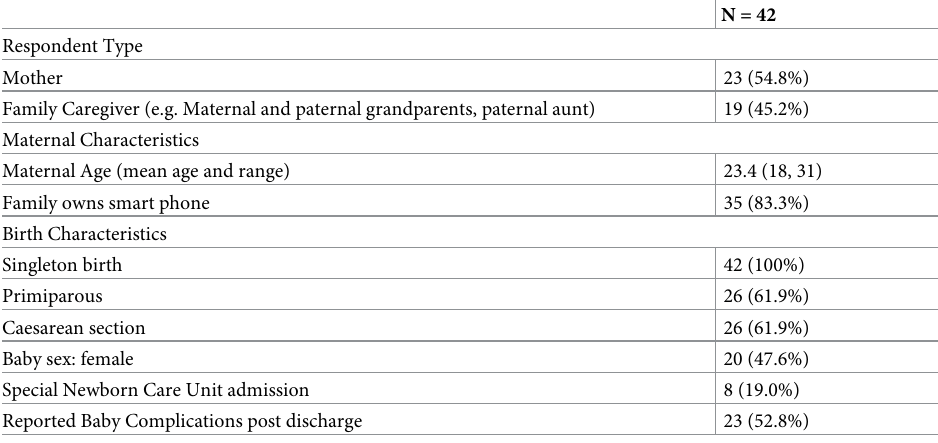
Table 2. Demographic characteristics of